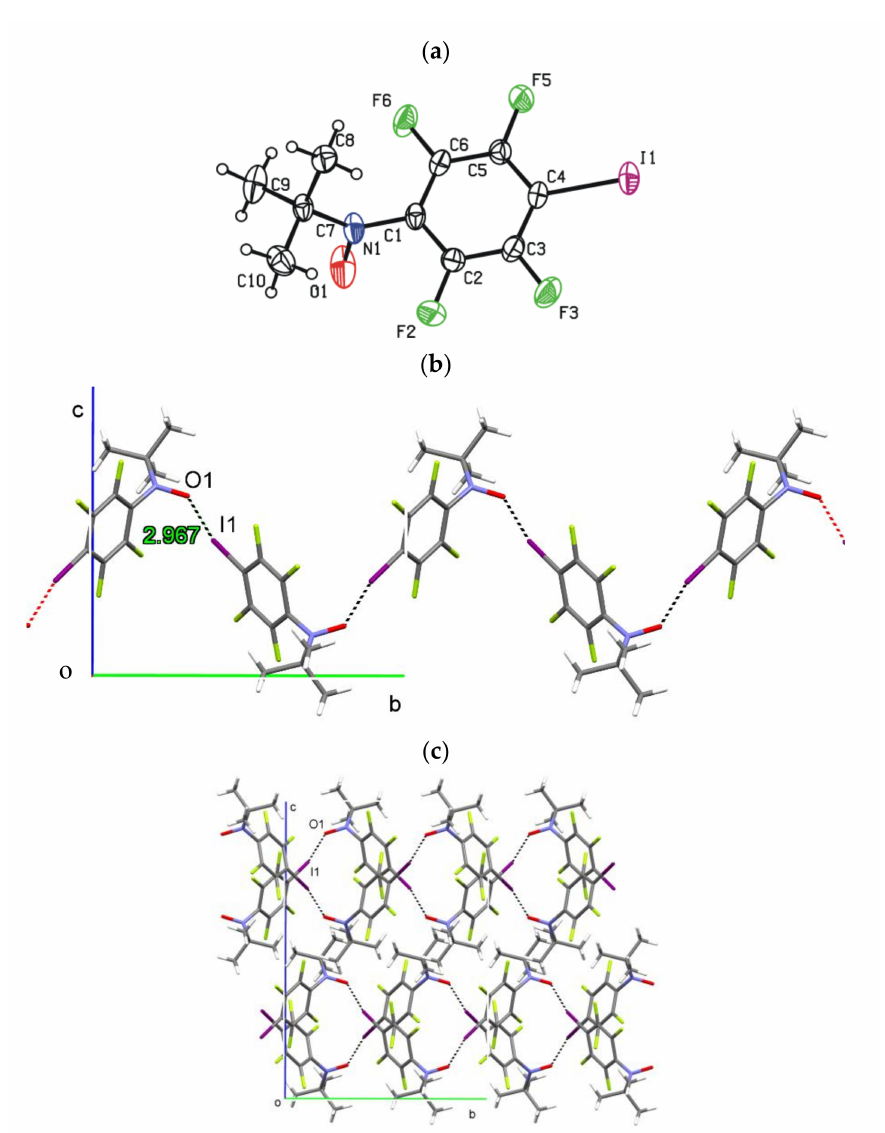
Figure 4. Molecular structure ( a ) and fragments of crystal structure ( b , c ) of nitroxide radical 4 (the thermal ellipsoids are drawn at the 30% probability